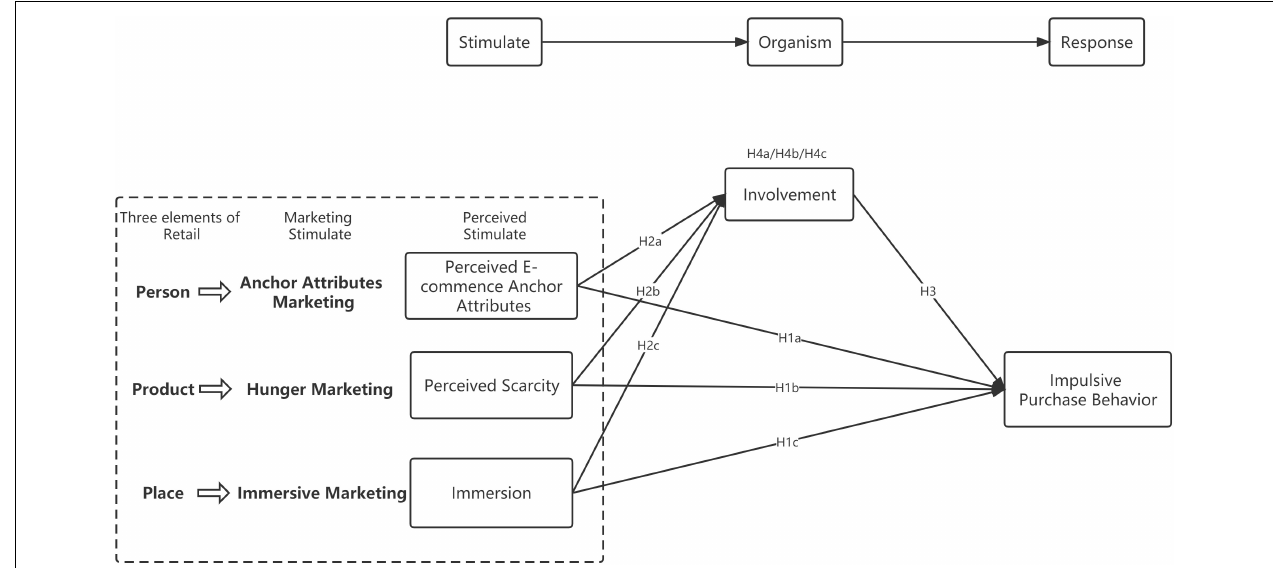
FIGURE 2 | Research